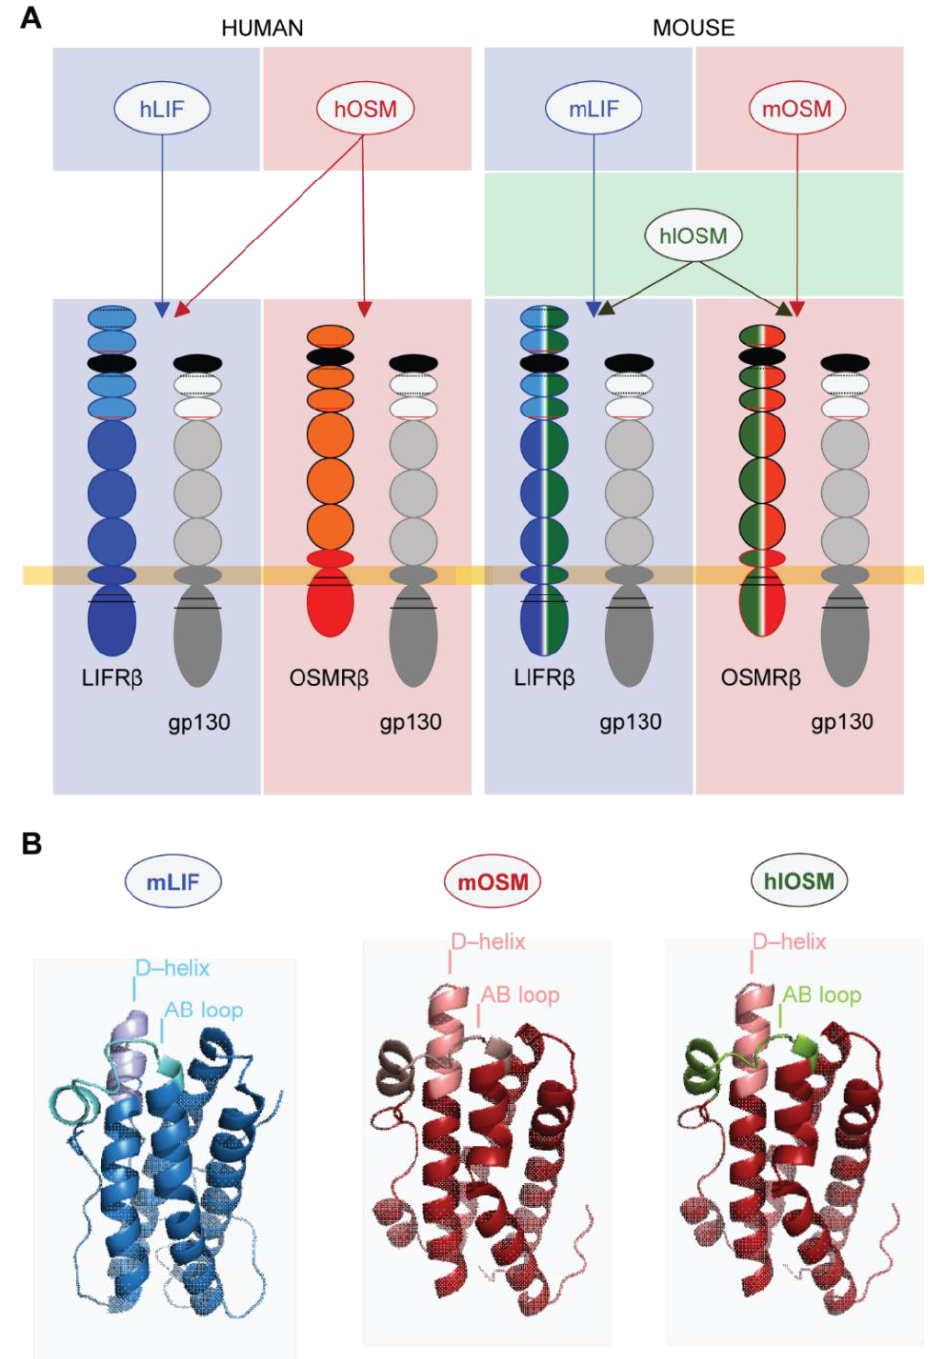
Figure 1 . Species-specific binding differences of LIF and OSM to OSMR and LIFR in human and mice. ( A ) Schematic illustration of species-specific binding properties of human OSM (hOSM), human LIF (hLIF), murine OSM (mOSM) and murine LIF (mLIF). Note that the generation of a human-like OSM (hlOSM) mutant mimics the binding properties of hOSM with the OSMR and LIFR in mice [17]. ( B ) Three-dimensional model of mOSM, mLIF and hlOSM. The AB loop and D–helix of each molecule constitute structural determinants of their species-specific receptor binding properties. The hlOSM protein contains the human AB loop sequence, which is highlighted in green.